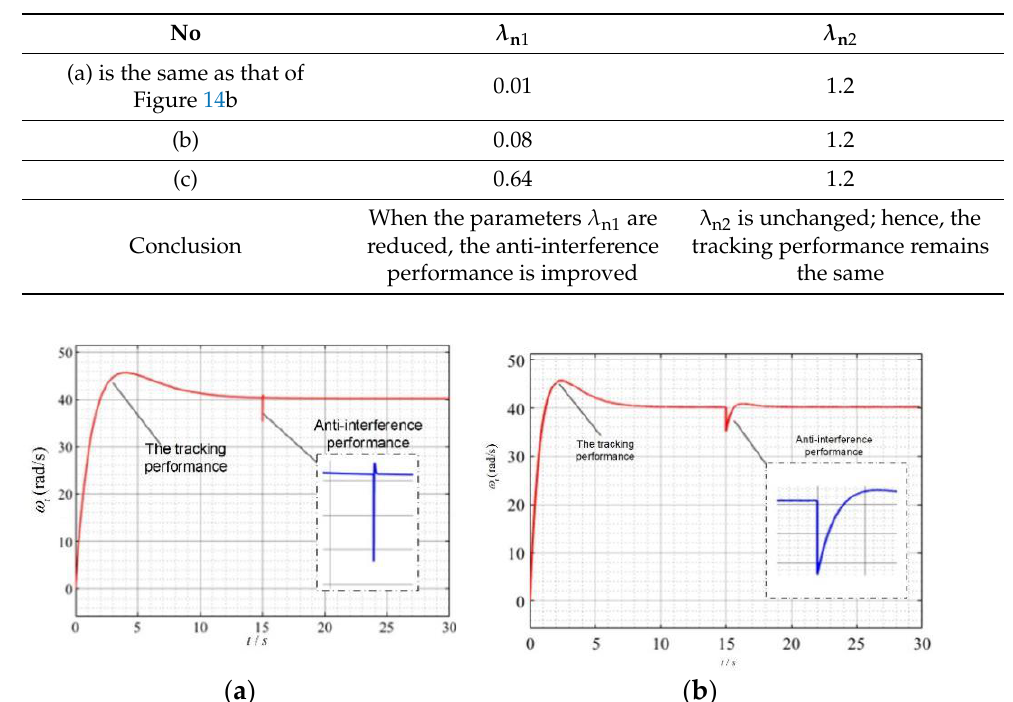
Figure 14. The output speed response curve of the system: ( a ) scheme (a); ( b ) scheme (b); ( c ) scheme (c).